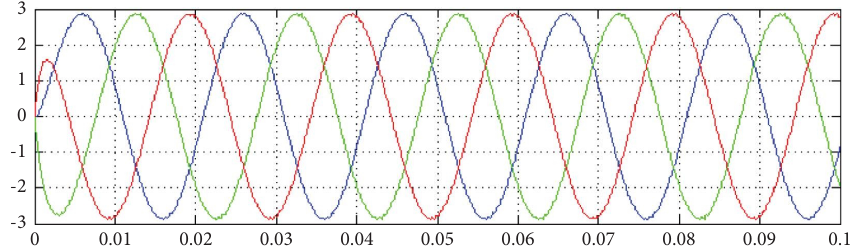
Figure 19: Inductive load current for three-phase 9-level inverter.